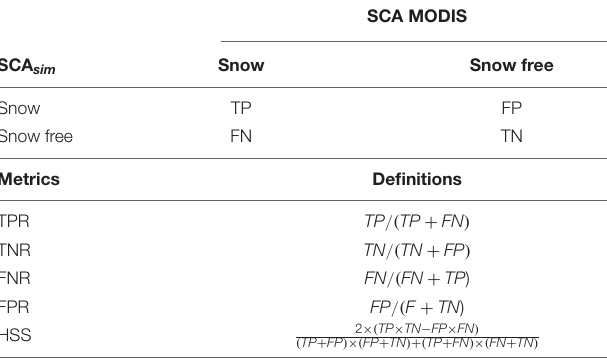
TABLE 4 | Description of confusion matrix between simulated and MODIS SCA, and the evaluation metrics used for model